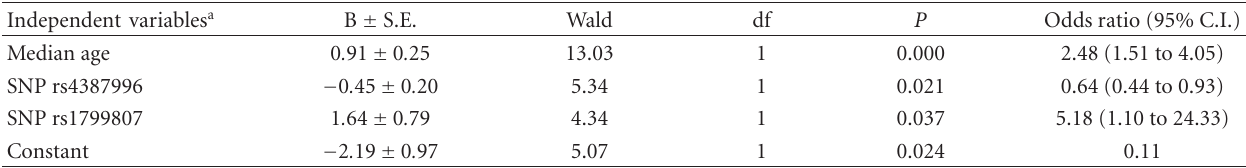
Table 2: Results from a forward stepwise multiple logistic regression in which leprosy (0 = contact control, 1 = patient) was the dependent variable.